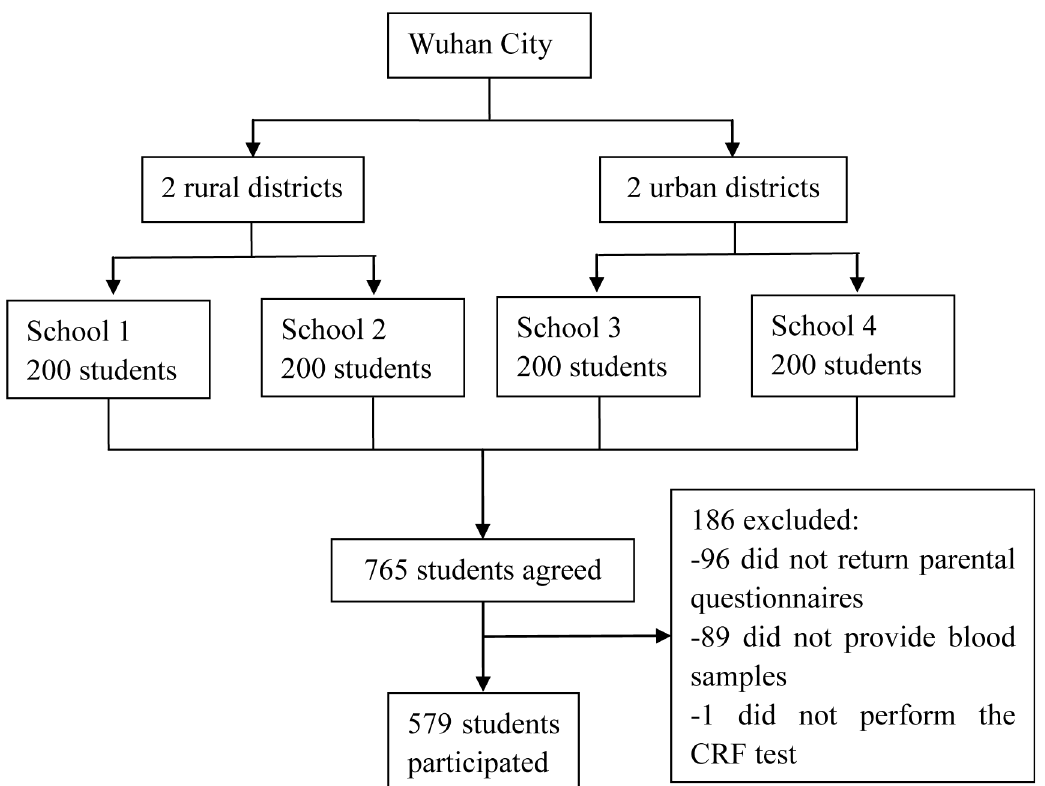
Fig 1. Flow of the participants through the